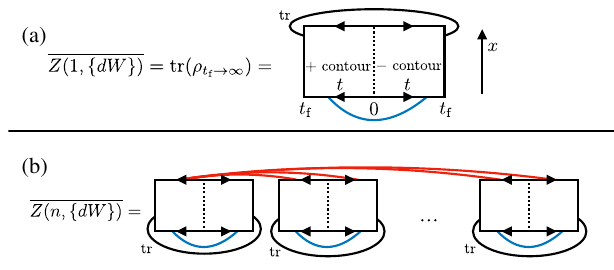
FIG. 3. (a) Keldysh representation of a single replica. Time evolution of the noise averaged density matrix is captured by two Keldysh contours running horizontally; the spatial dimension is represented by the vertical lines. The trace operation is repre- sented by a black line connecting final times t , for a selected f position x . The noise average (lower blue line) yields the usual path integral representation of a Lindblad equation, with char- acteristic contour coupling terms. (b) Keldysh representation of n replicas. In addition to the coupling of contours within each replica, the average over the stochastic term couples all replicas (upper red lines). The trace operation acts on each replica individually, and is indicated by black lines.